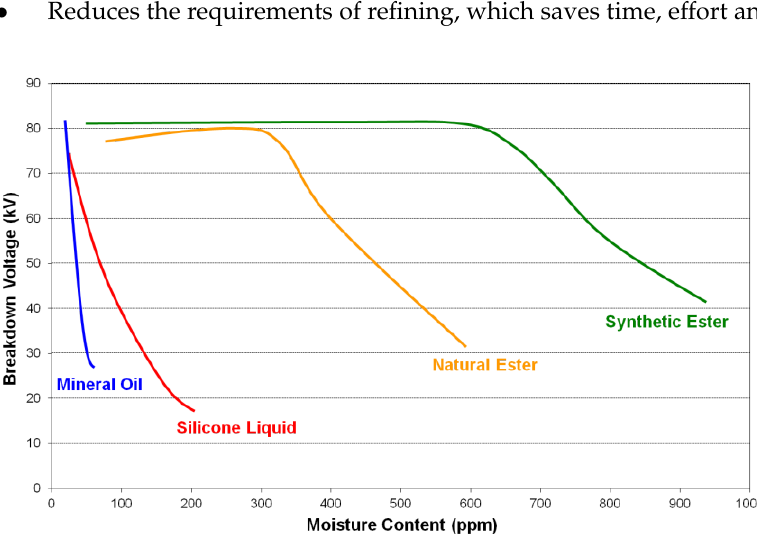
Figure 7. Effect of moisture content on breakdown voltage for different insulating fluids.